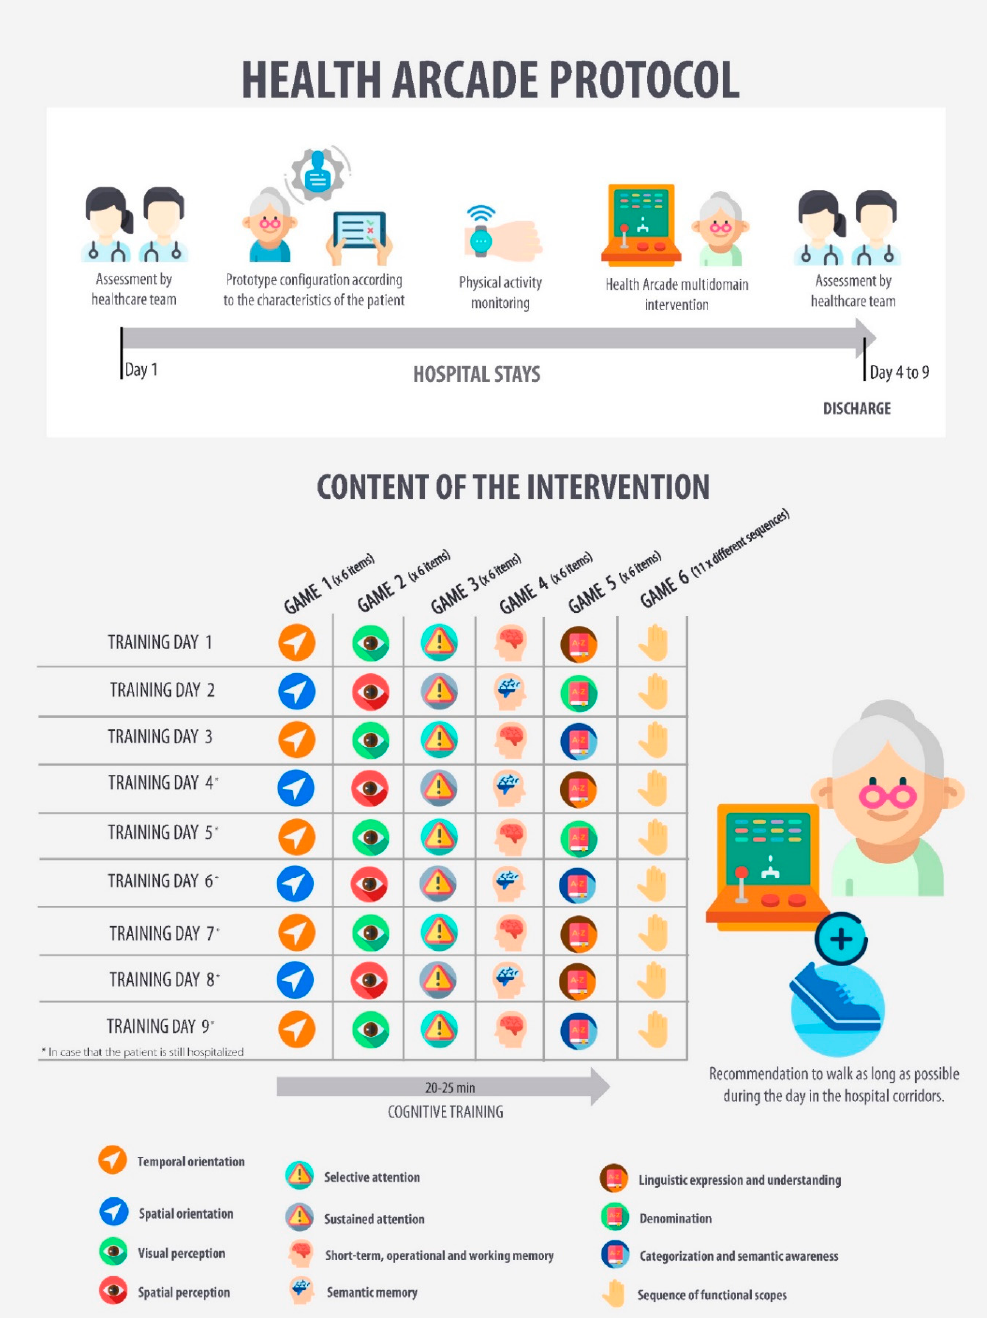
Figure 2. Health Arcade